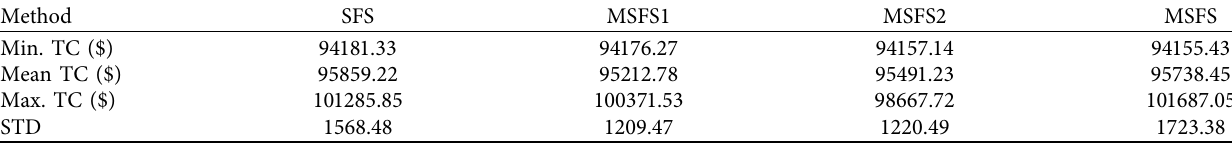
Table 11: Comparisons of result obtained by SFS methods for the 69-bus system with the objective function of total cost. Method